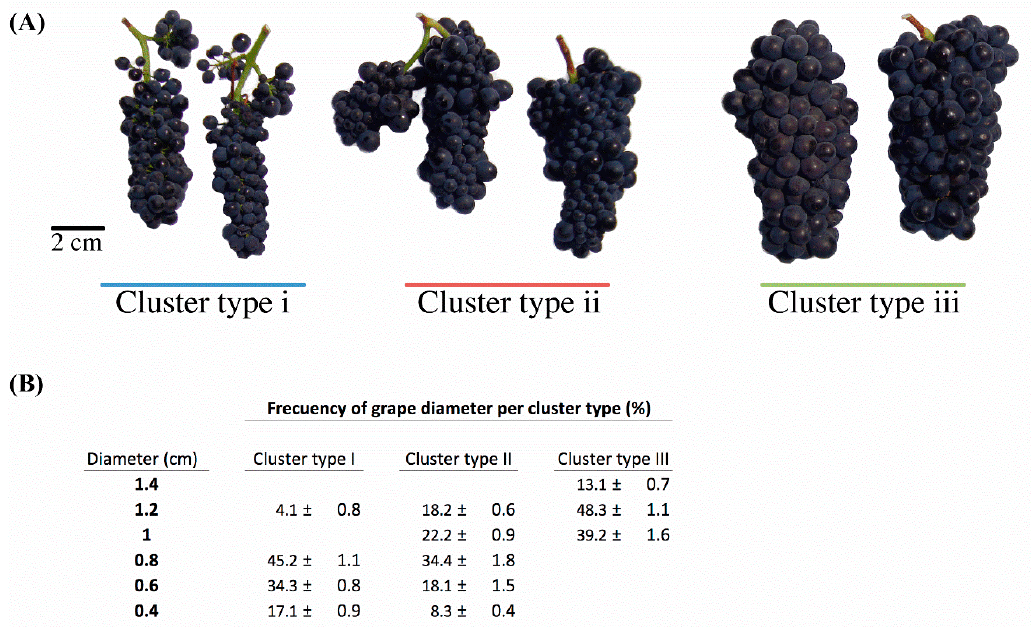
Figure 1. ( A ). A comparison of the three Pinot noir grape cluster types. Scale bar = 2 cm. ( B ). Berry diameter at the ripe stage. Values are mean ± standard deviation (n = 50). Table 1. Grape and wine analysed in the experiment including some basic compositional parameters. Values are mean ± standard deviation (n = 50 and n = 6 for grapes and wines,